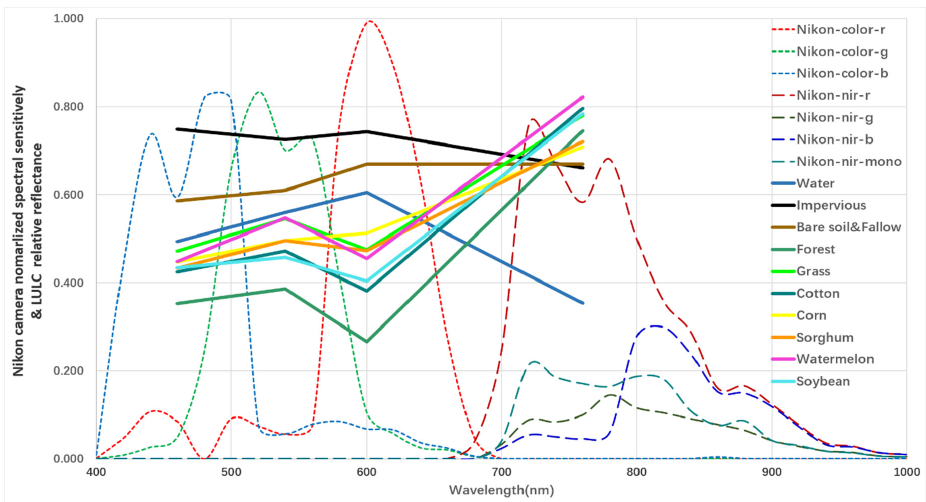
Figure 3. Normalized spectral sensitivity of two Nikon D90 cameras and relative reflectance of 10 land use and land cover (LULC) classes. The dotted lines represent different channels of the RGB camera (Nikon-color-r, Nikon-color-g, and Nikon-color-b) and the modified NIR camera (Nikon-nir-r, Nikon-nir-g, Nikon-nir-b, and Nikon-nir-mono). The solid lines represent the relative reflectance of 10 LULC classes.